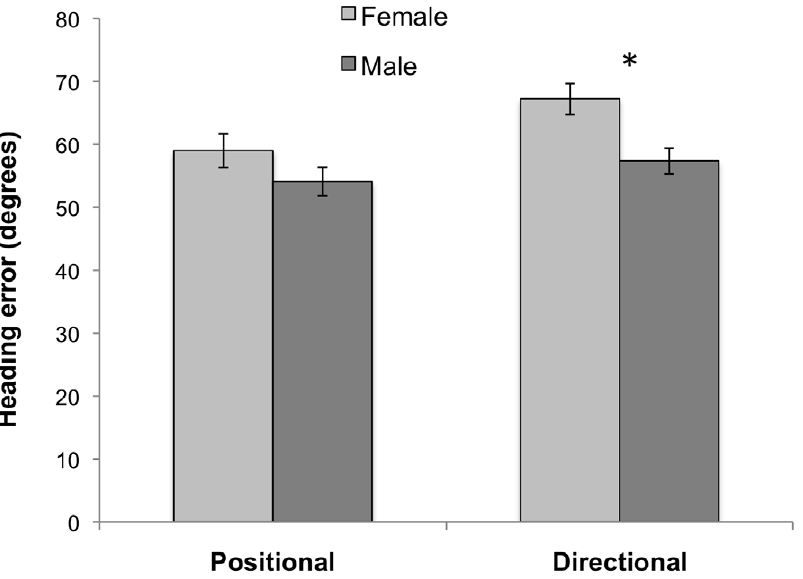
Figure 3. Heading error in all-directional and all-positional cue environments. Error bars represent SE.